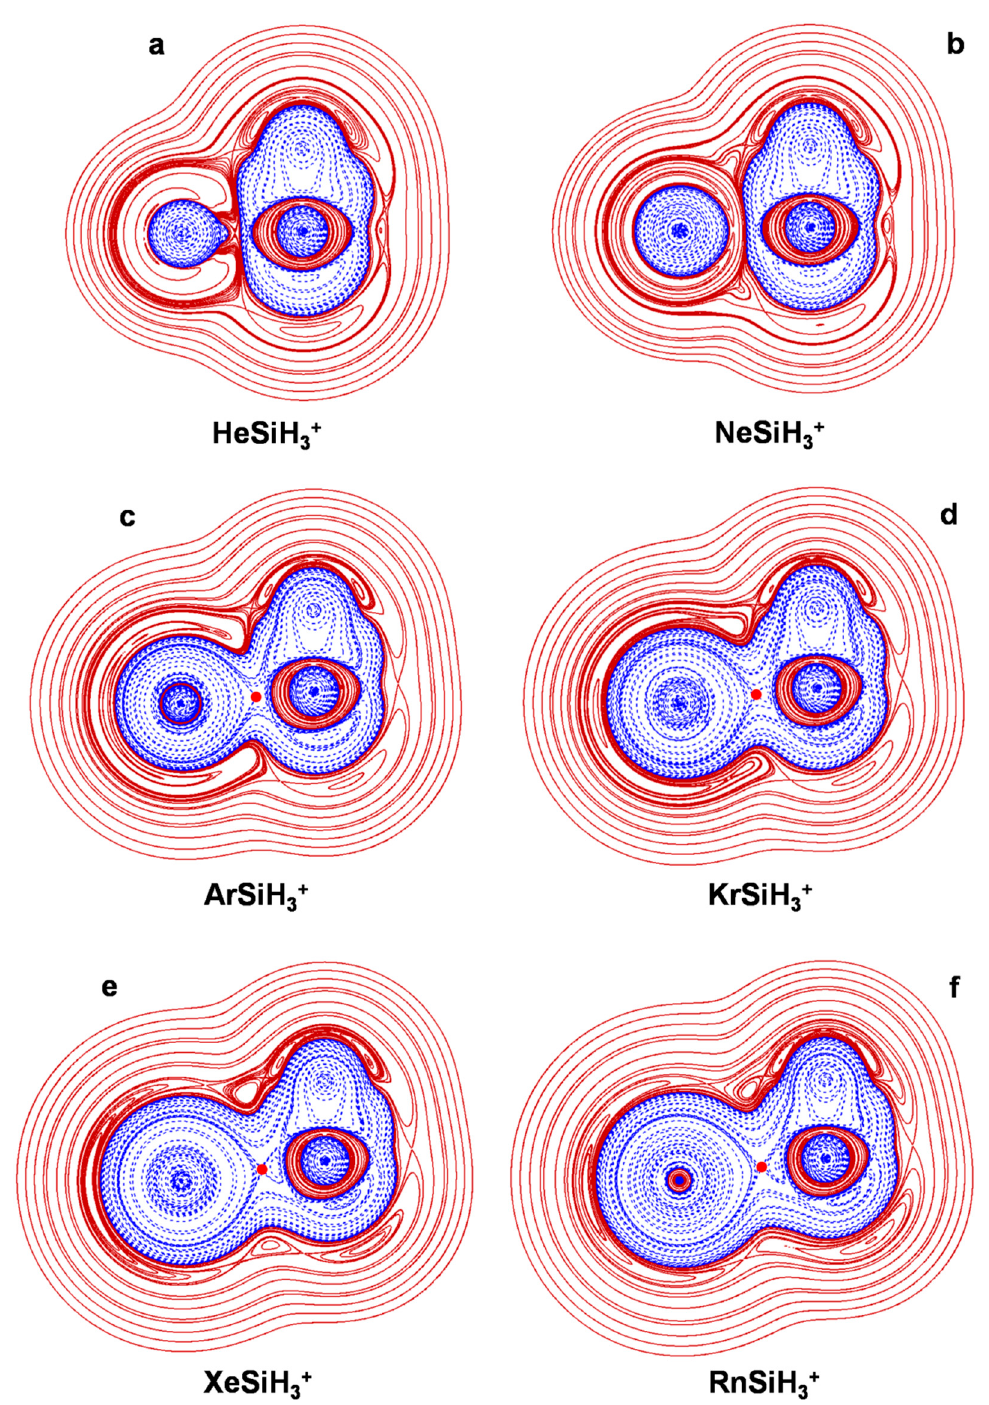
Figure 2. 2D plots of H ( r ) in the symmetry plane of ( a ) HeSiH 3+ ; ( b ) NeSiH 3+ ; ( c ) ArSiH 3+ ; ( d ) KrSiH 3+ ; ( e ) XeSiH 3+ ; ( f ) RnSiH 3+ (solid/brown and dashed/blue lines correspond, respectively, to positive and negative values). The red dots represent the HCPs.